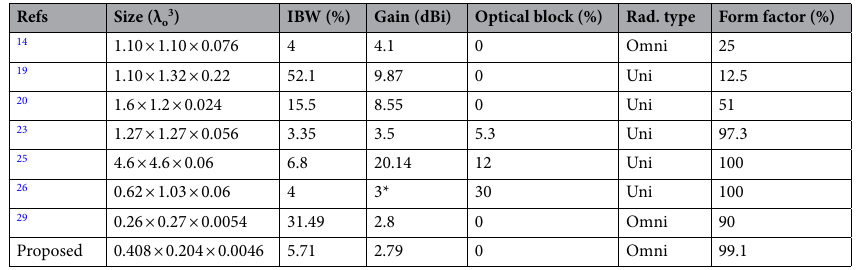
Table 1. Performance comparison of the proposed design with other solar cell antennas. IBW impedance bandwidth, λ o free space wavelength at the center frequency of the IBW. *Realized gain.